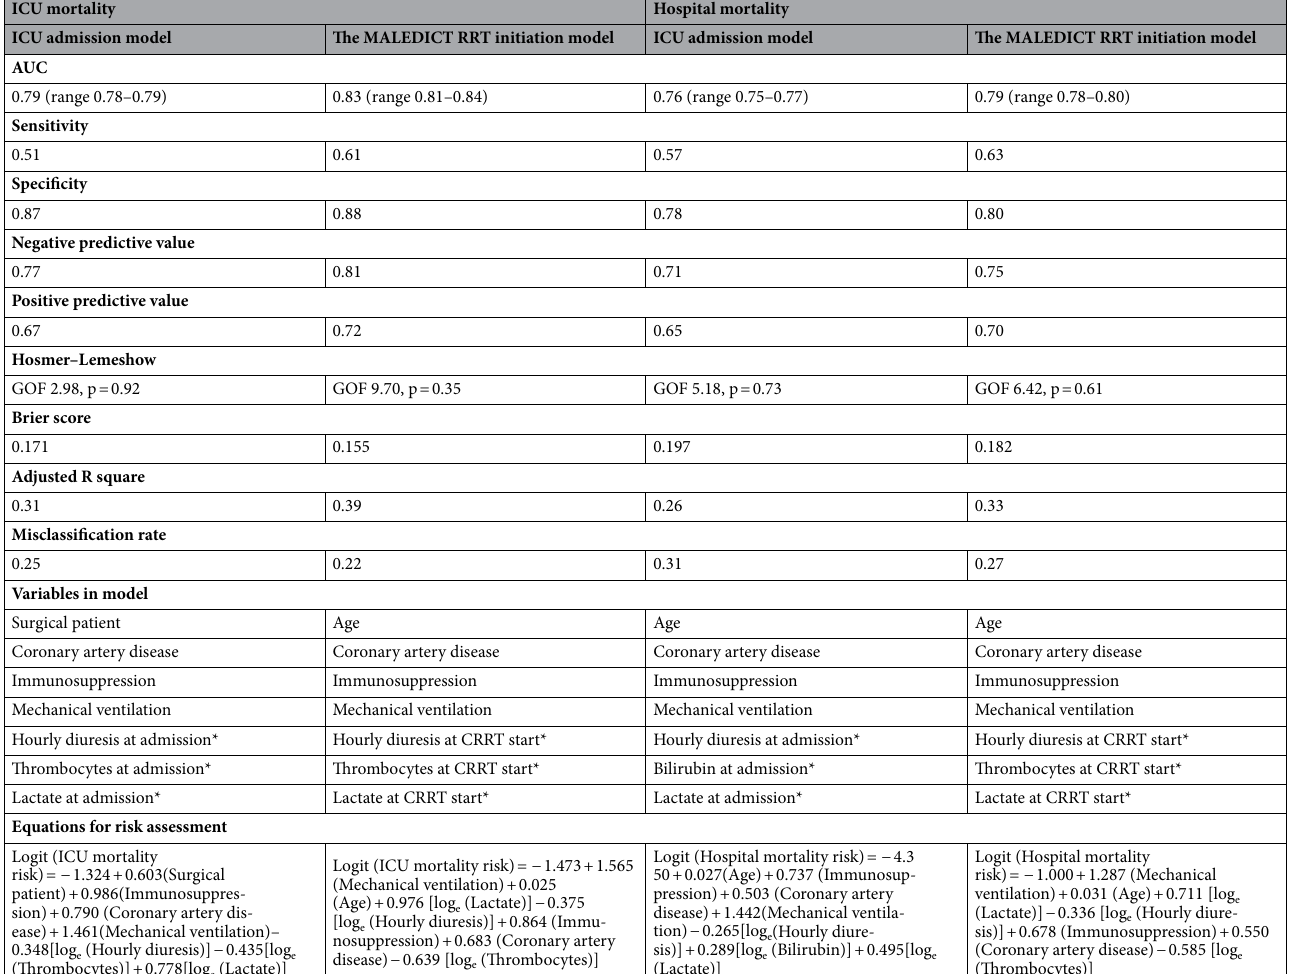
Table 2. Final multivariable models for ICU mortality and hospital mortality developed in the CRRT patient cohort. ICU intensive care unit, CRRT continuous renal replacement therapy. *log e